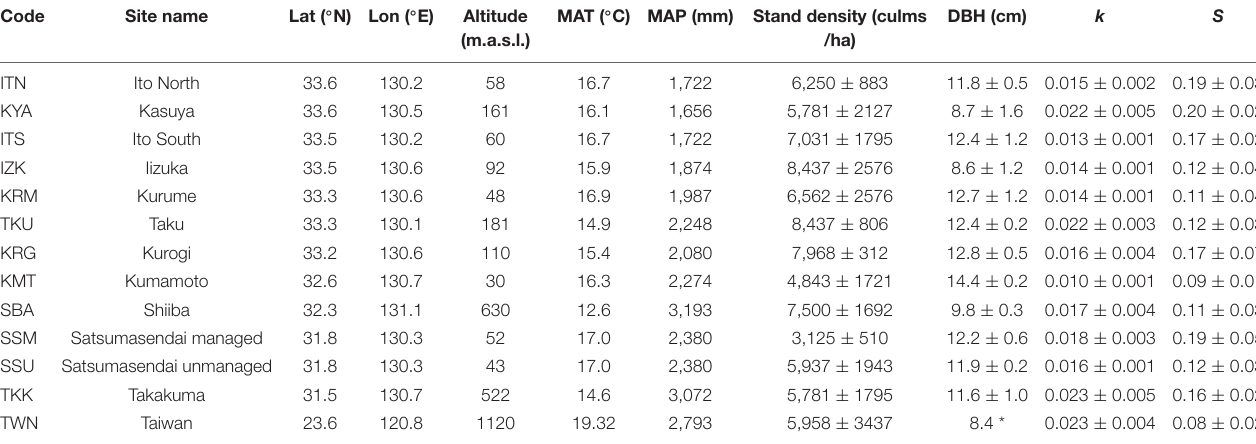
TABLE 1 | Location, environmental features, and mean values of stand structure characteristics (stand density and DBH) and decomposition parameters ( k and S ) for the 13 sites. Code